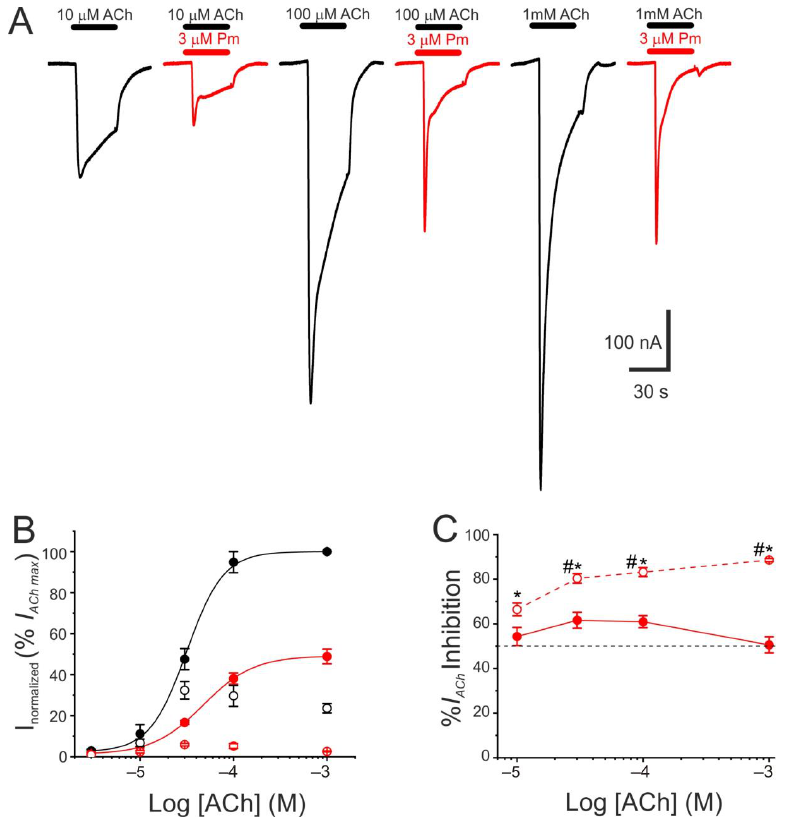
Fig.2 Figure 2. Pharmacological profile of nAChR blockade by Pm. ( A ) Representative I ACh s evoked by ACh at 10 µ M (left), 100 µ M (middle), or 1 mM (right), either alone (black recordings) or together with 3 µ M Pm (red recordings). ( B ) ACh concentration- I ACh amplitude relationship when the cell was bathed with either just ACh (black color; filled symbols denote I p values whereas open circles correspond to I ss ) or ACh plus 3 µ M Pm (red symbols). The EC 50 values of the sigmoid curves fitting the experimental data were 31 µ M (range 11–52 µ M) and 47 µ M (range 46–49 µ M) for control and 3 µ M Pm, respectively. ( C ) Percentage of I p (solid symbols) and I ss (open symbols) inhibition elicited by 3 µ M Pm when co-applied with the indicated ACh concentrations. (*) indicates significant differences between I p and I ss inhibition, for each ACh concentration ( p < 0.05, paired t -test). (#) indicates significant differences among I ss inhibition at 10 µ M ACh and other concentrations ( p < 0.05, ANOVA followed by Bonferroni t -test). Each point of panels B and C is the average of 4–14 cells from 1–2